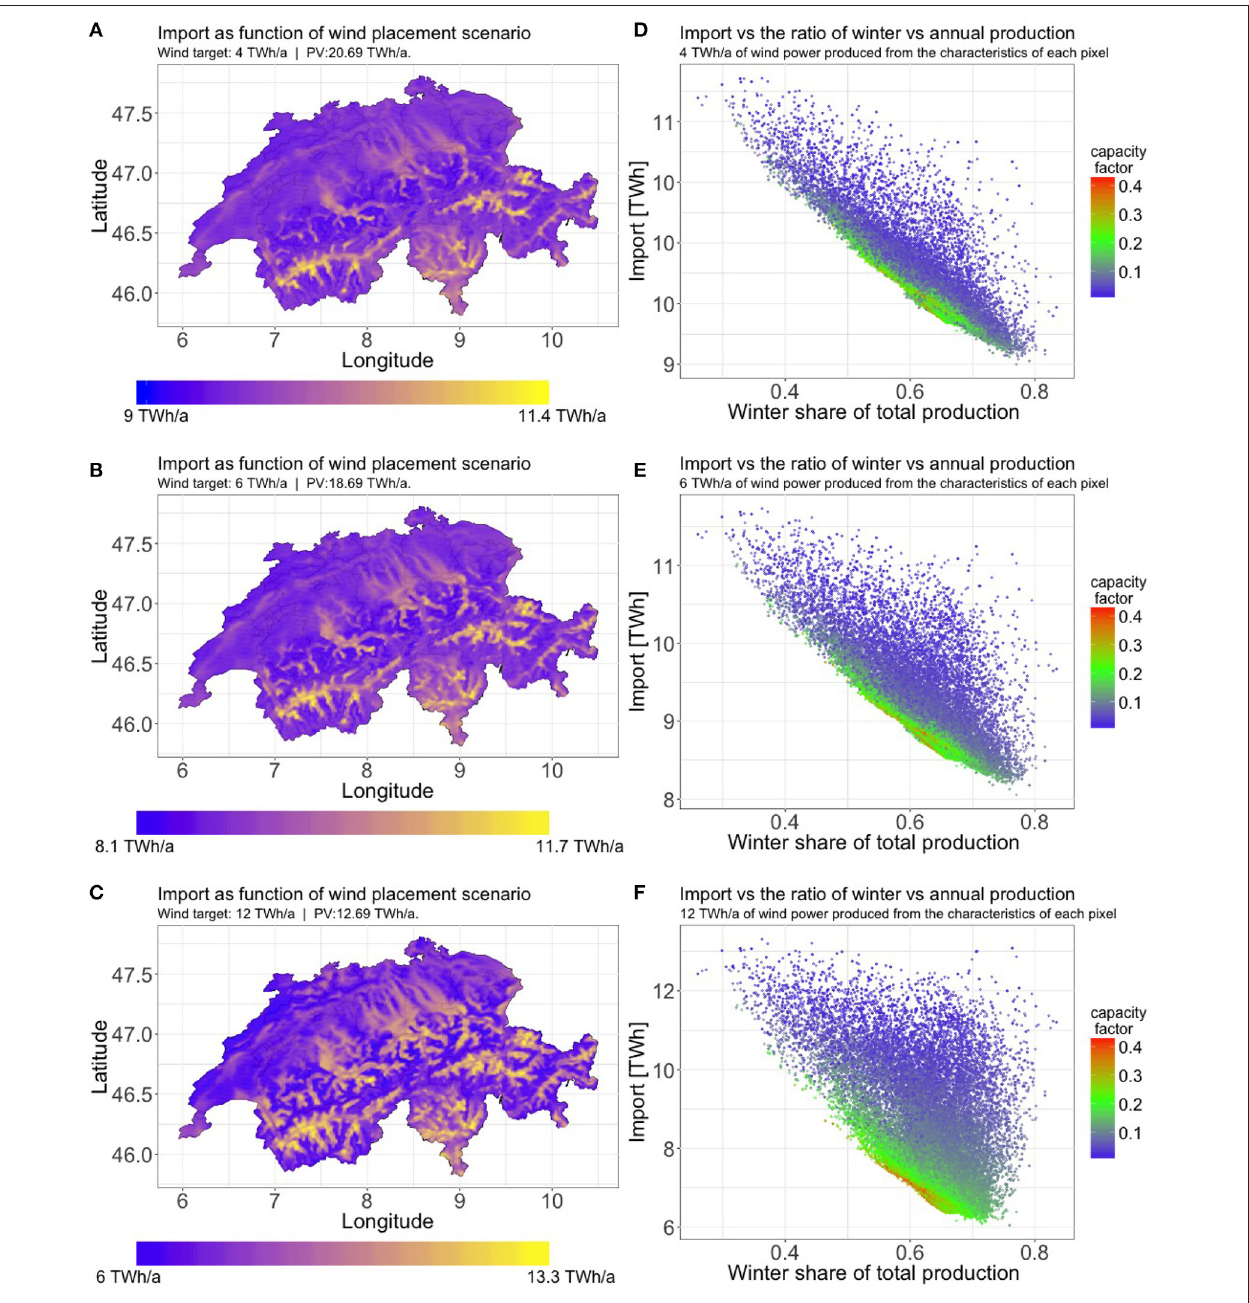
FIGURE 7 | Left ( A–C ): Producing various annual wind power targets (4, 6, or 12 TWh/a) from the characteristic time series of each COSMO-1 pixel. The Import required to balance the system is plotted in each pixel. We can see a clear relation to the topography. Right (D–F) : The relation between import and the share of total production that is produced in winter, for the same data as on the left. The highest capacity factors are found around the 60% winter production range. Each point in the plot represents the time series from a 0.01 ◦ pixel in the COSMO-1 dataset, scaled to produce 4, 8, or 12 TWh/a. Winter is defined as November through